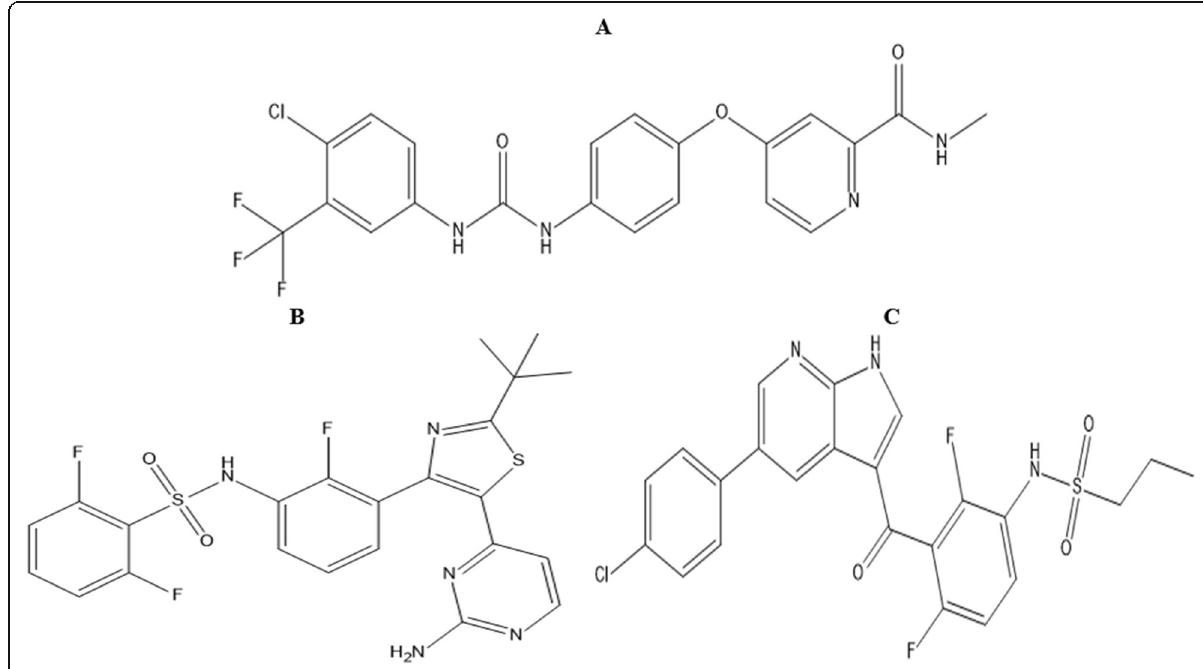
Fig. 1 Chemical structures of a sorafenib, b dabrafenib, and c